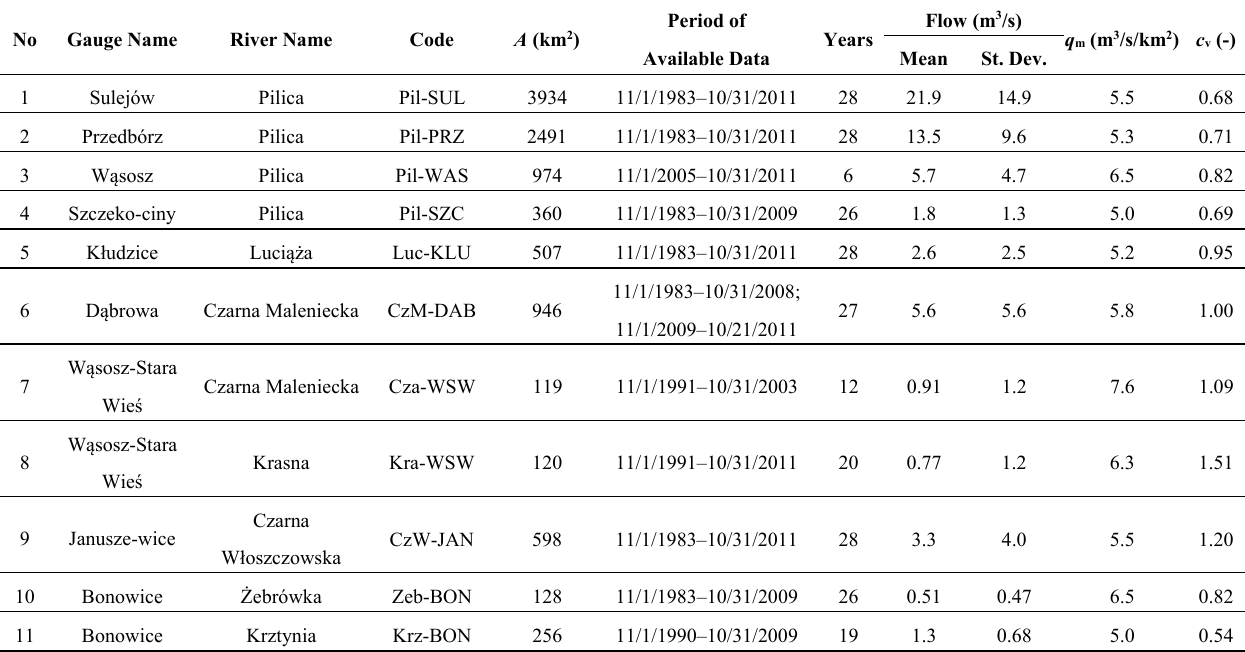
Table 2. List of IMGW-PIB flow gauges in the Sulejów reservoir catchment used in this study with data availability and selected catchment